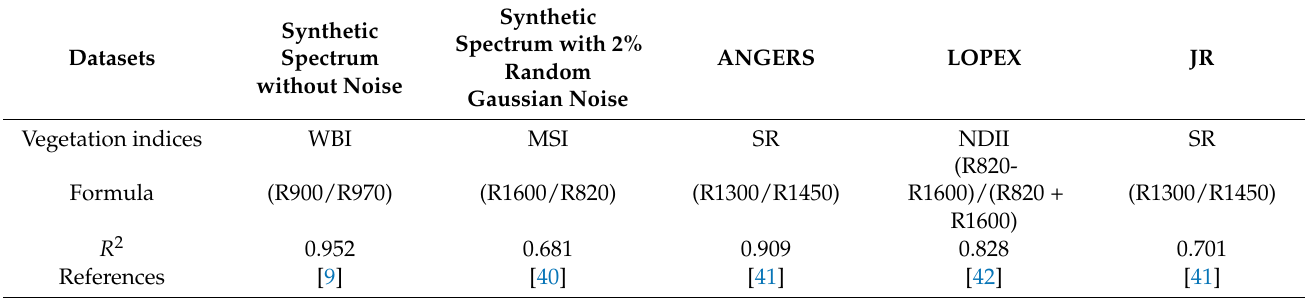
Table 2. Selected four published Vegetation Indices (VIs) (WBI, MSI, SR, and NDII) with the highest R 2 for the different